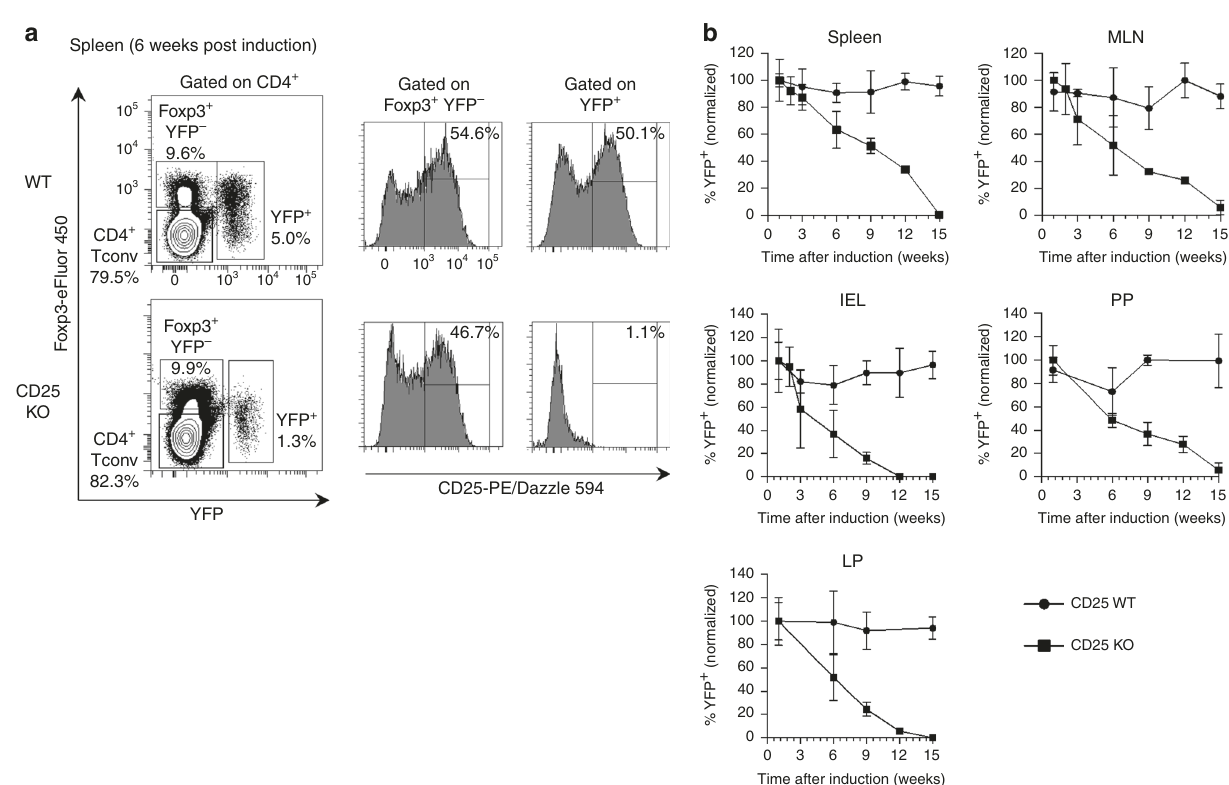
Fig. 5 Impaired peripheral homeostasis of Tregs with selective CD25 deletion. a Representative contour plots and histograms showing splenocytes from CD25 fl ox/Foxp3eGFP − Cre-ERT2/R26Y mice (shown as CD25 KO) and reporter controls, analyzed 6 weeks after tamoxifen induction. b Proportional abundance of YFP + cells in lymphoid and non-lymphoid tissues analyzed at indicated time points after tamoxifen induction. YFP + cell numbers were calculated as a percentage of total Tregs (the combined Foxp3 + and YFP + populations) and normalized to an initial induction ef fi ciency of 100% measured 1 week after tamoxifen induction. MLN mesenteric lymph nodes, PP Peyer ’ s patches, IEL intraepithelial lymphocytes of small intestine, LP lamina propria of small intestine ( n = 3 mice per time point; error bars ± SD). Data are representative of ( a ) or pooled from ( b ) three independent